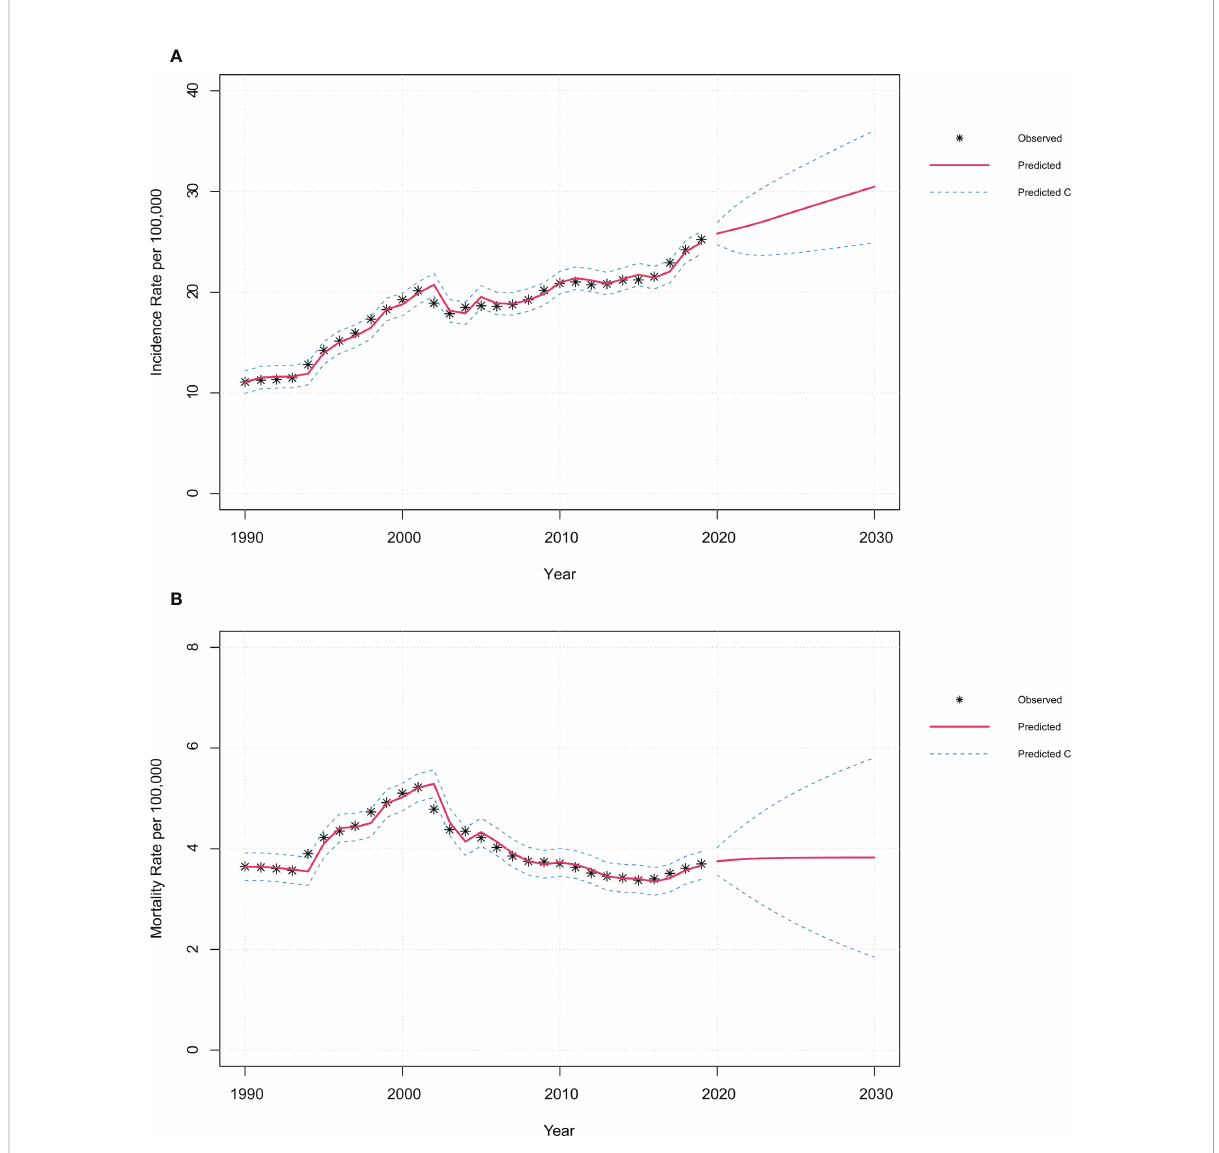
FIGURE 6 |Time-series plots of incidence and mortality of FeBGCs among AYAs in 1990 – 2030 in China. Observed and predictive values of incidence (A) and mortality (B) rates among AYAs from 1990 to 2030 in China. CI, con fi dence interval; FeBGCs, female breast and gynecologic